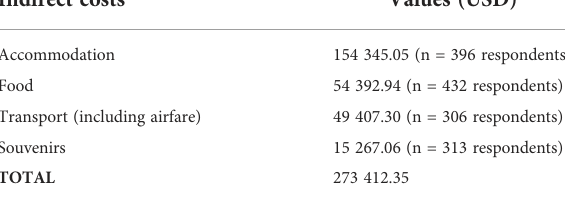
TABLE 4 Indirect costs associated with manatee watching from January 2020 to February